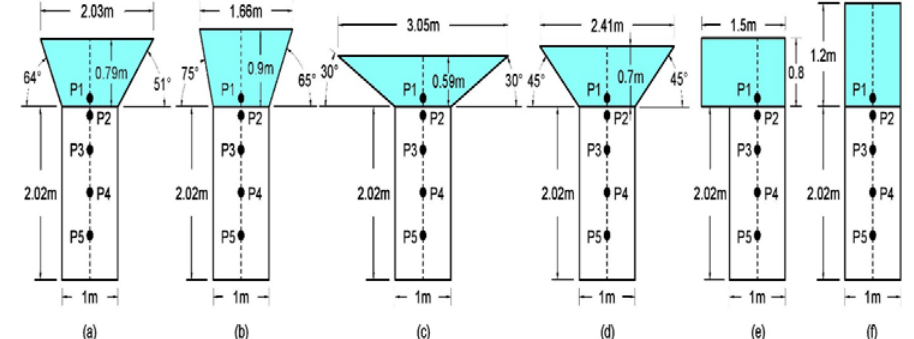
Fig. 1. Reservoir shapes: (a) R1 (Mahabad Dam), (b) R2 (Tignes Dam), (c) R3 (30 degree); (d) R4 (45 degree);